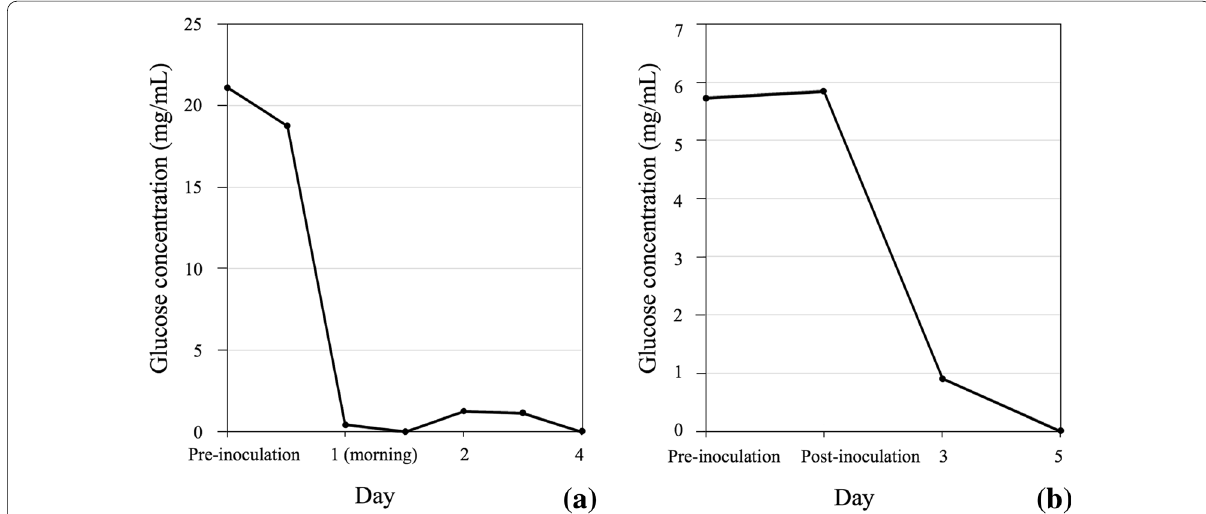
Fig. 5 Glucose utilization during scale-up biomass production in 300 L fermentation. a Streptomyces sp. strain SMCD with glucose depleted by the afternoon of Day 1, with requirement for glucose addition; b Penicillium sp. SMCD with glucose only depleted after 5 days of fermentation